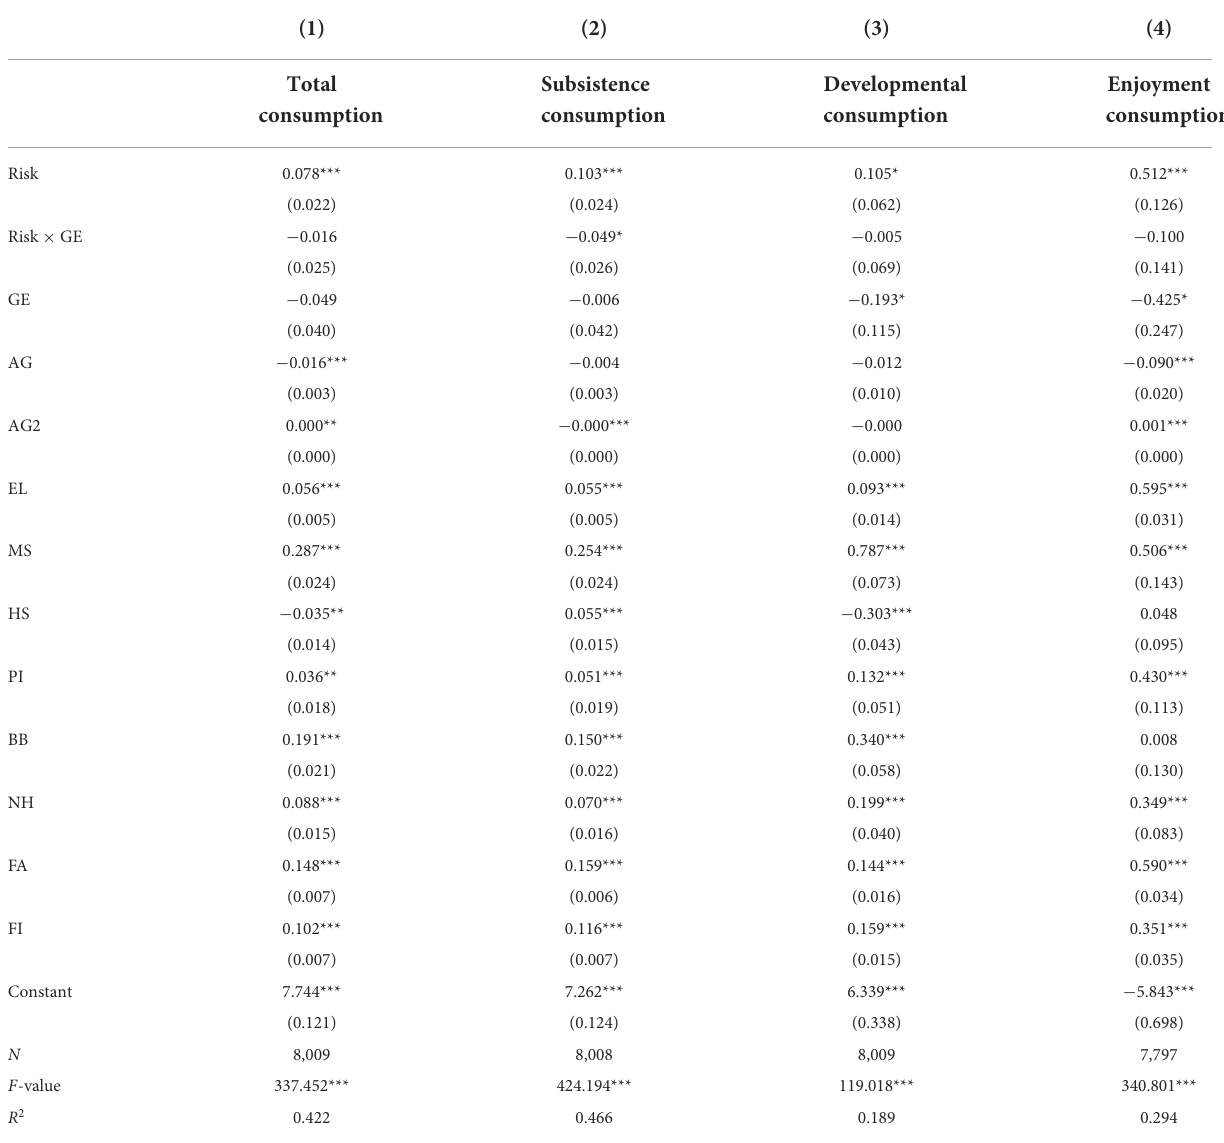
TABLE 7 Results of gender heterogeneity